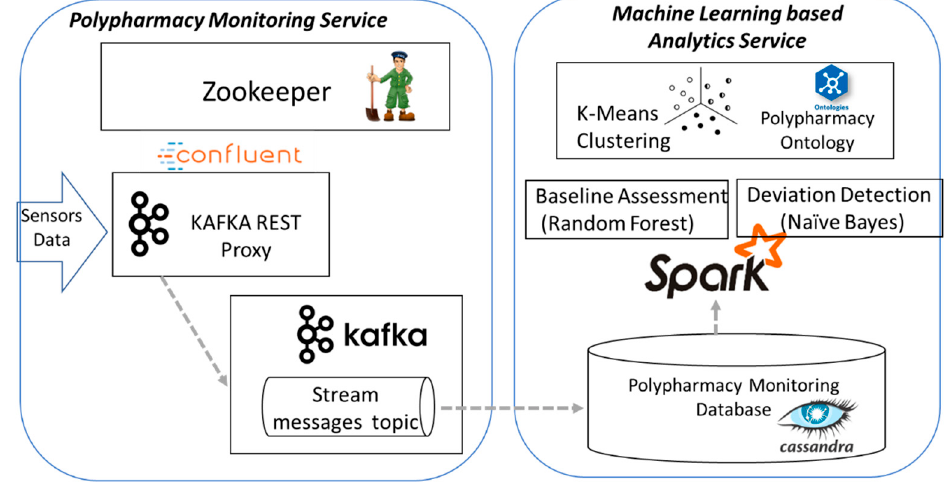
Figure 3. Sensor data management and machine learning (ML)-based analytics.